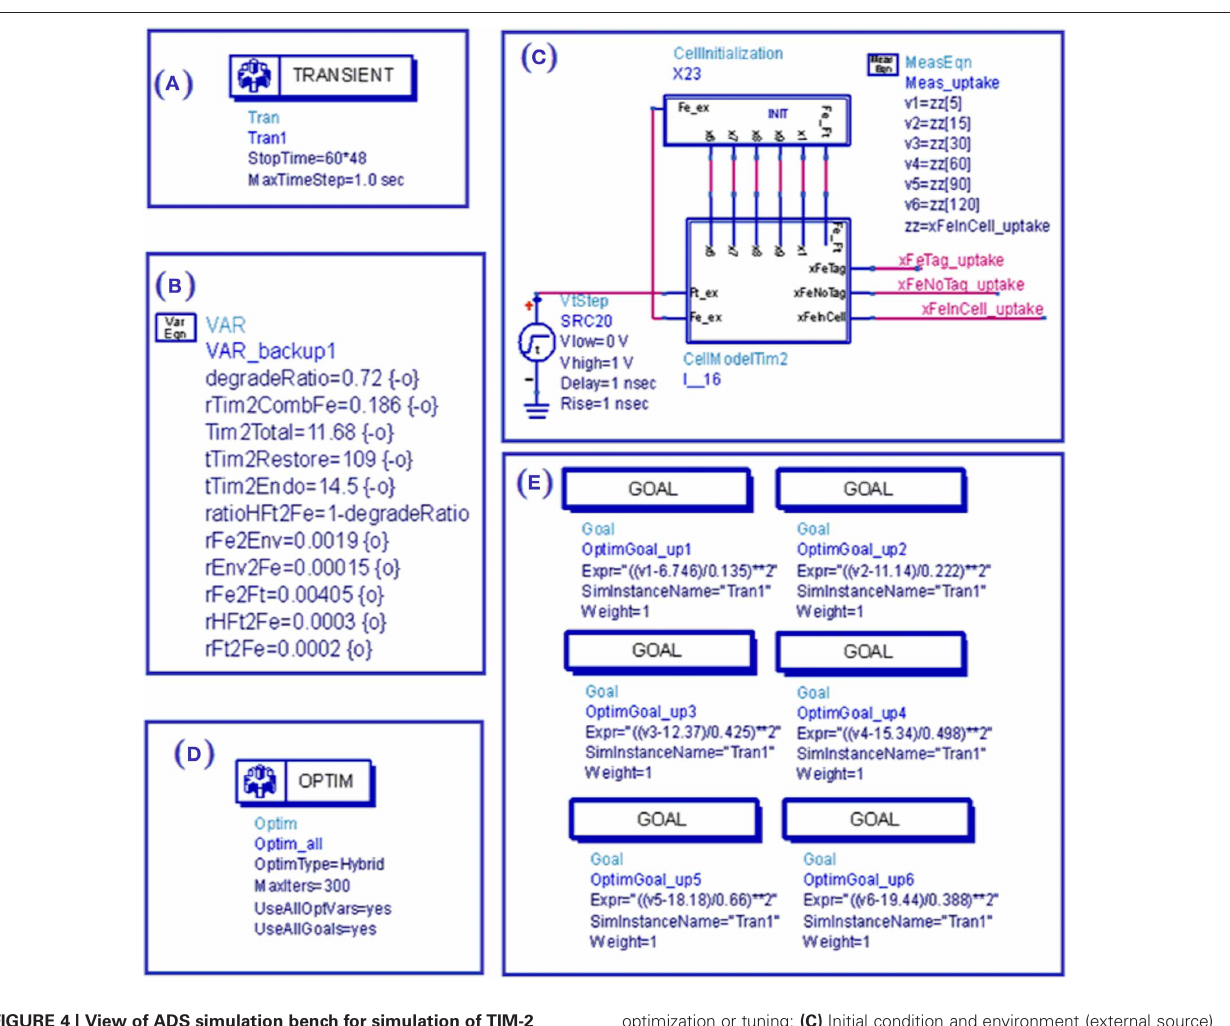
FIGURE 4 | View of ADS simulation bench for simulation of TIM-2 pathway model. (A) Simulation setup defines the time duration and resolution; (B) Variable setup defines parameters and their range for